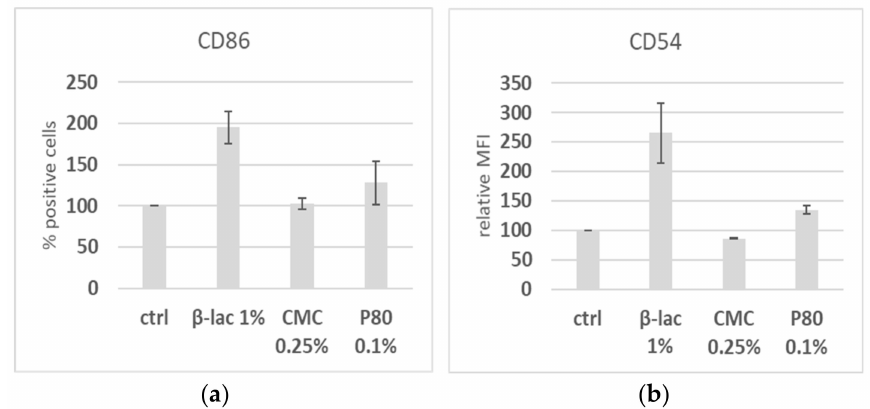
Figure 1. Changes in cell surface expression levels of CD86 ( a ) and the mean fluorescent intensity (MFI) of CD54 ( b ) in MUTZ-3 cells exposed to the indicated substances for 24 h, as determined by flow cytometry ( n = 2, error bars show standard deviations). Data are normalized to the control